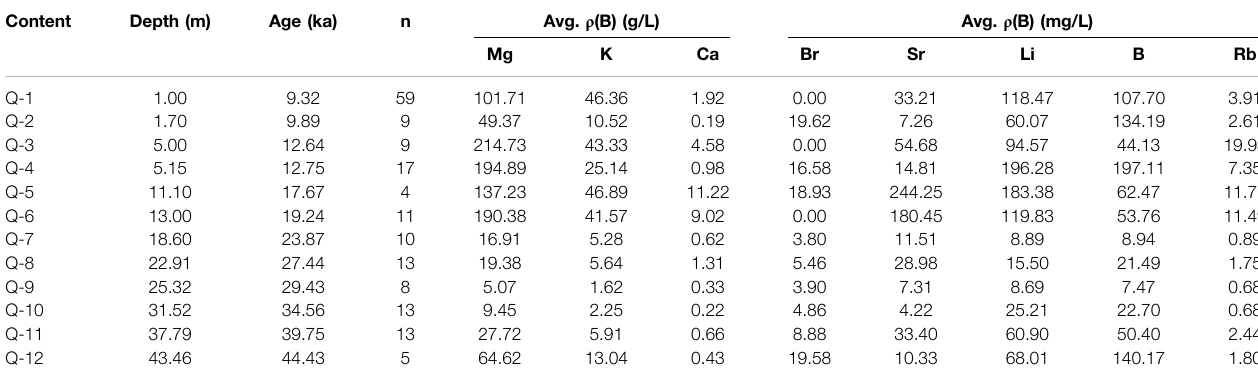
TABLE 1 | Chemical components of fl uid inclusions in halites from the ISL1A drillhole.